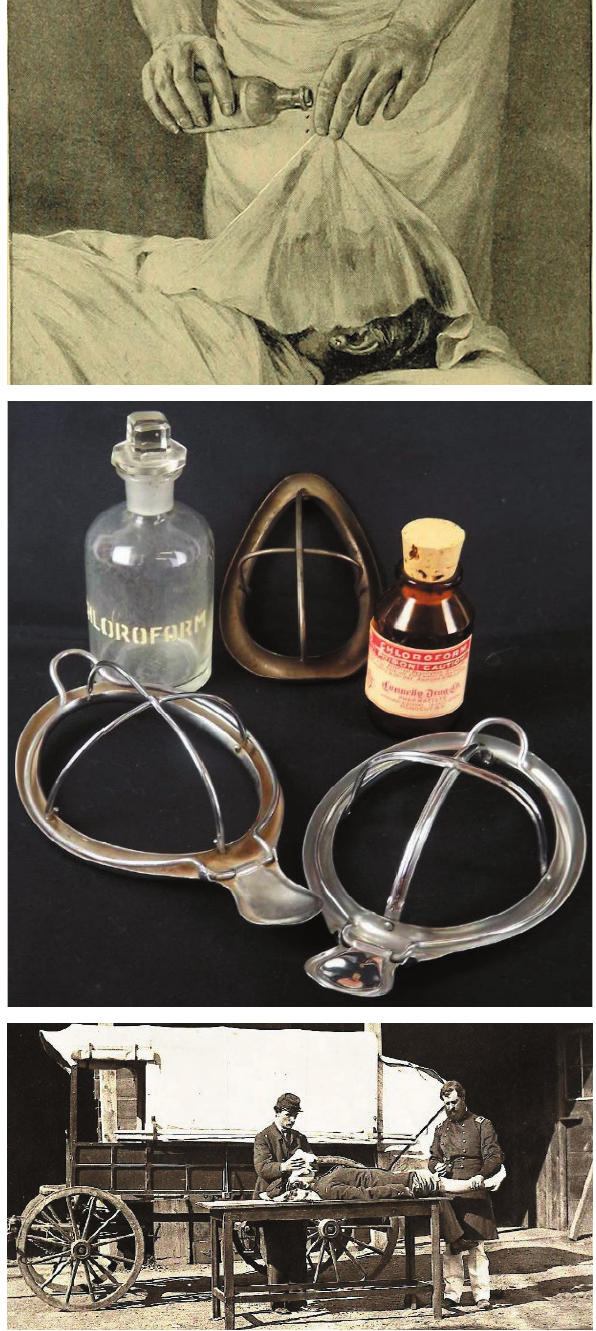
Figure 3. Top : Inducing chloroform anesthesia by inhalation through a cloth. Source: https://survivalstronghold.com/wp-con- tent/uploads/2016/11/Administering_Chloroform_RAG.png. Mid- dle : Chloroform flasks and masks for holding a textile material over the patient’s nose and mouth. Source: